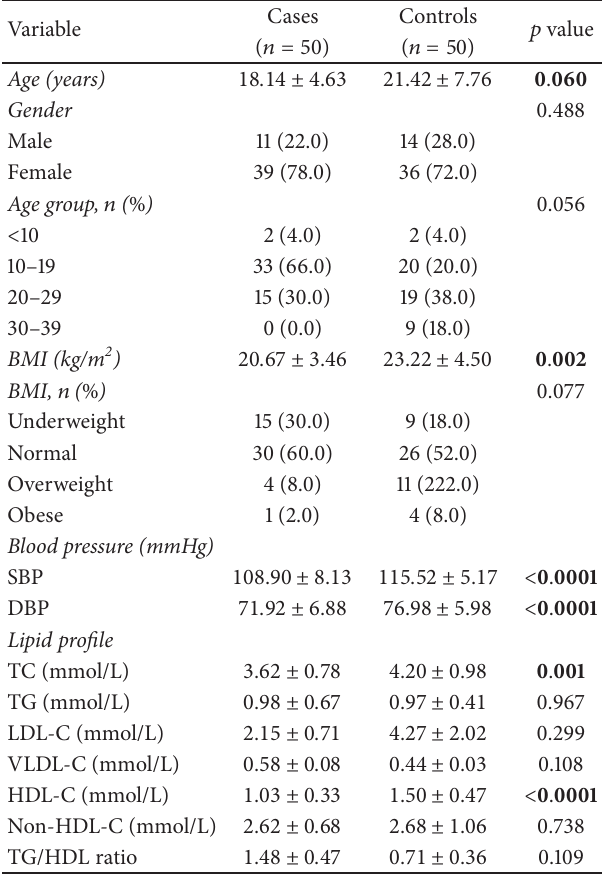
Table 1: Demographics and clinical characteristics of participants.